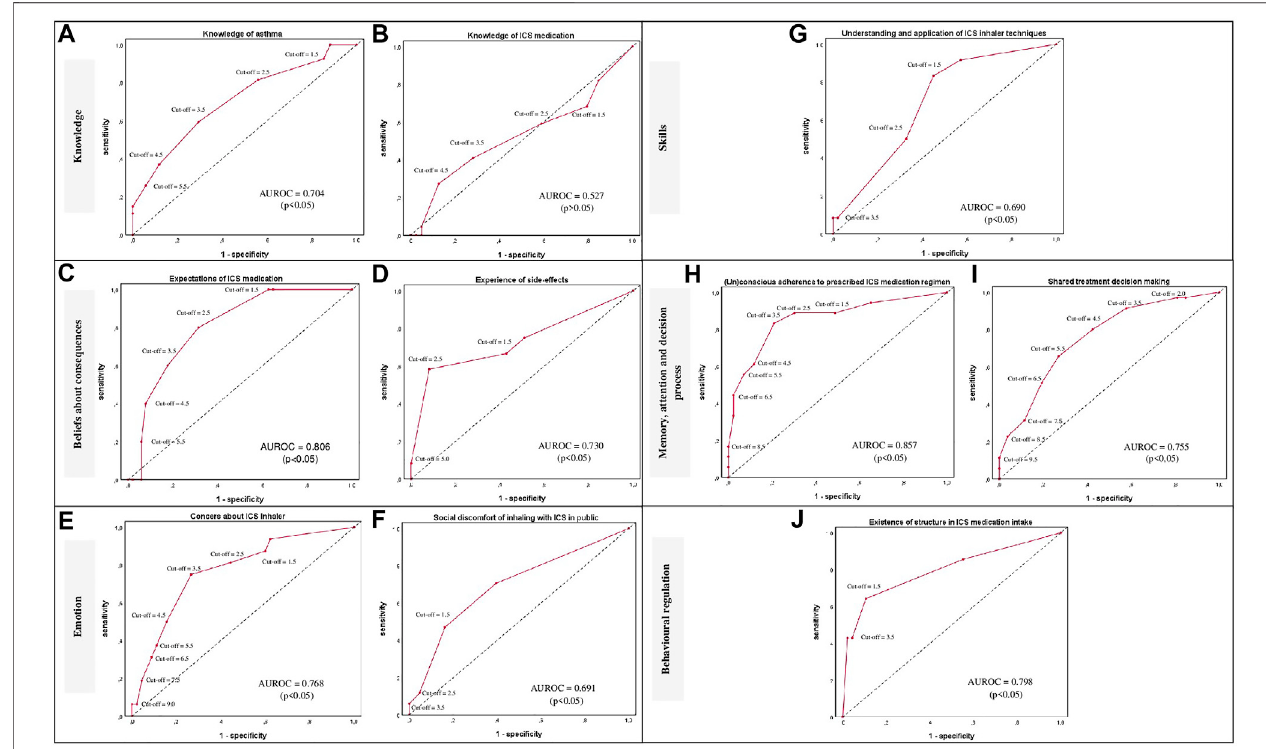
FIGURE 3 | ROC curves per barrier (A – J) are provided per TDF-domain for the classi fi cation of patients in presence or absence of a self-management barrier using various cut-offpointsofthe sumscoresperbarrier. TheROCcurvesarepresented asred lines.The diagonaldashedline representsthelinethatisnobetter thanchanceat discriminatingbetweenthepresenceorabsenceofaself-managementbarrier.AdjuvantAUROCvaluesarepresentedpergraphprovidinganindicationoftheaccuracyofthe scores at discriminating between the presence or absence of a self-management barrier. Corresponding p -values ≤ 0.05 were considered statistically signi fi cant; Abbreviations: ROC: Receiver operating characteristic; TDF: Theoretical Domains Framework; AUROC: Area under the ROC; ICS: Inhaled Corticosteroids.